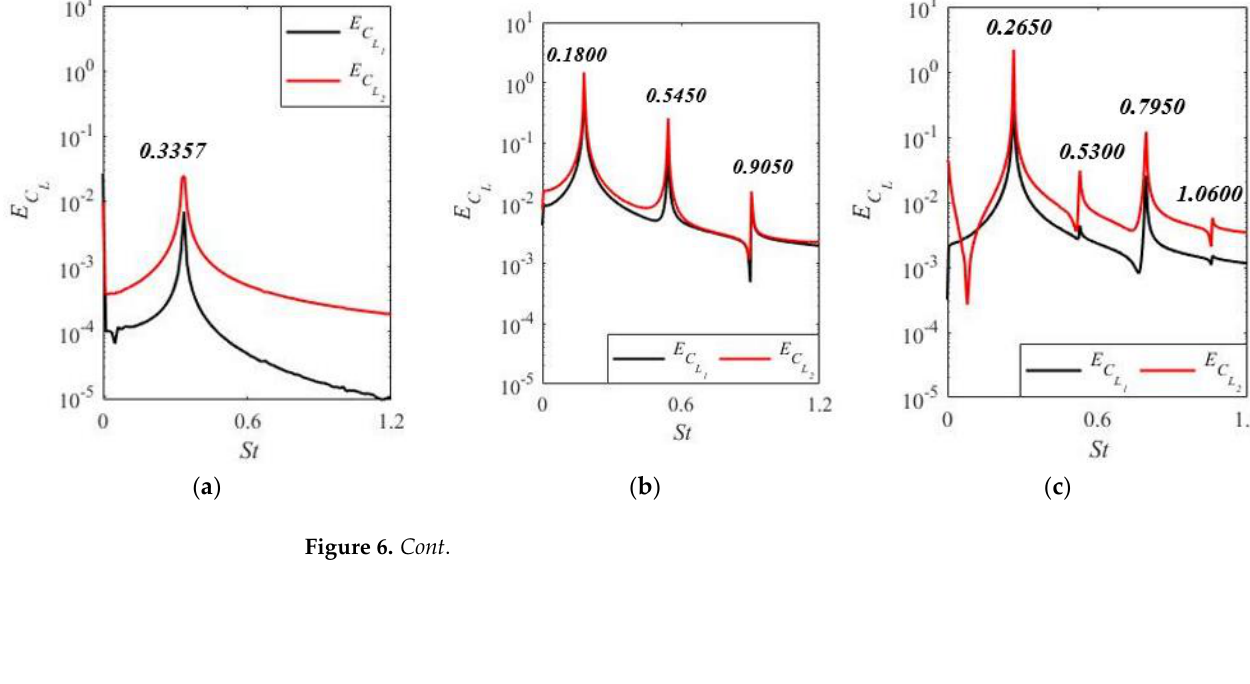
Figure 5. The pressure coefficient distribution for 𝐿/𝐷 = 1.56 . 𝑐 𝑝 = (𝑝̅ − 𝑝 0 )/( the pressure in the far field.